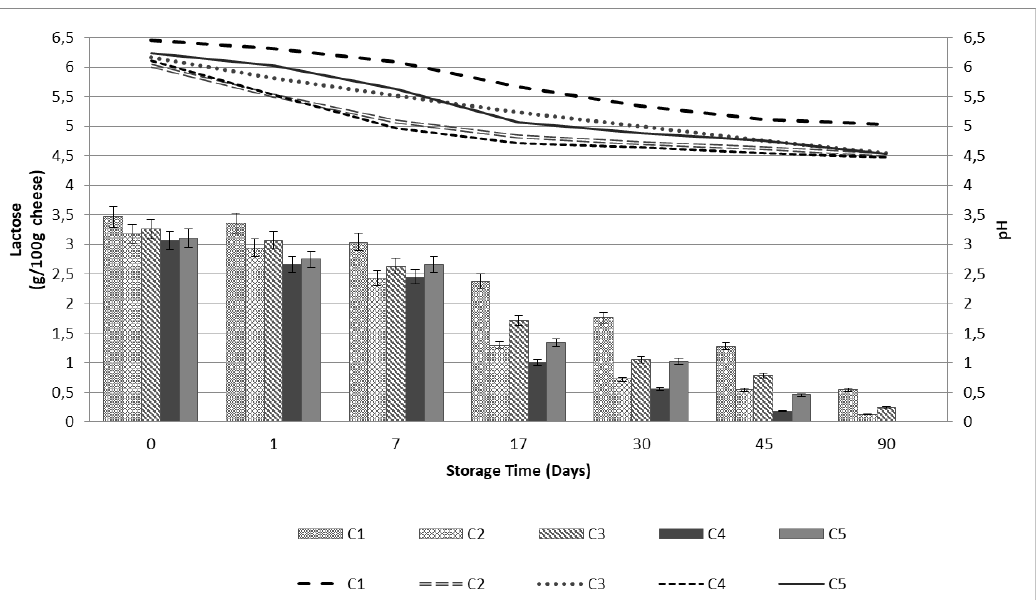
Figure 3. pH and lactose content (in g per 100 g cheese, on wet weight basis) of Feta-type cheeses